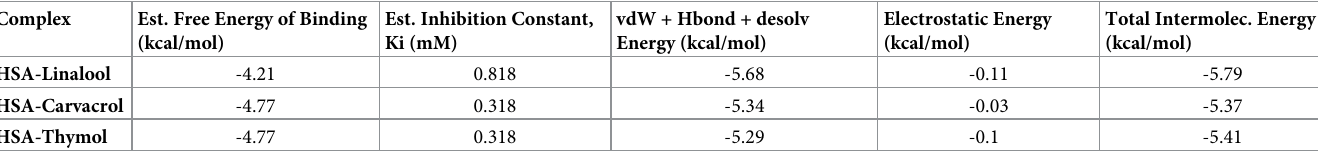
Est. Inhibition Constant, Ki (mM)